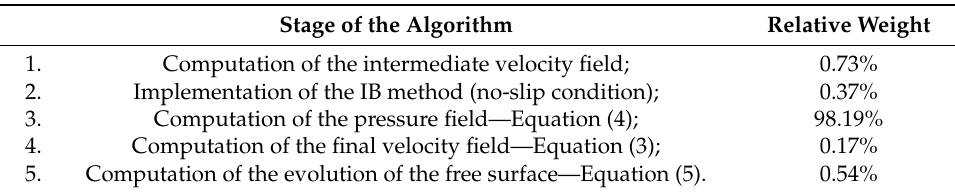
Table 4. Relative temporal weight of the main operations involved in the simulation of the wave propagating over the submerged elliptical shoal using 49.152 million